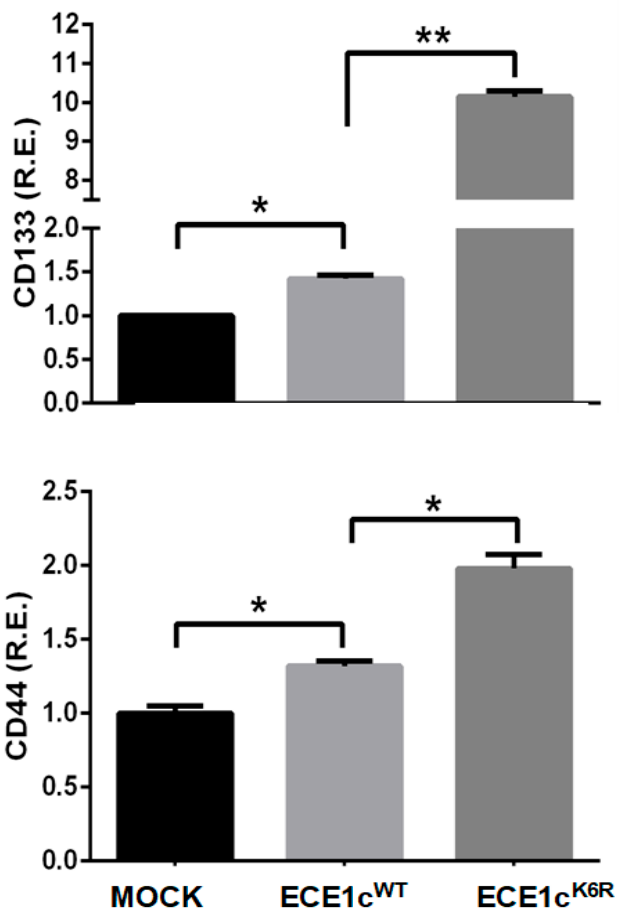
Figure 3. ECE1c K6R expression promoted increases in CD133 and CD44 transcript levels. U87MG cells expressing either Flag-tagged ECE1c WT or ECE1c K6R proteins were grown under normal conditions for 24 h. Then, mRNA levels of CD133 and CD44 genes were quantified using RT-qPCR. Data represent averages ± SEMs ( n = 3). Peritz F and Student’s tests were used. * p ≤ 0.05, ** p ≤ 0.01.